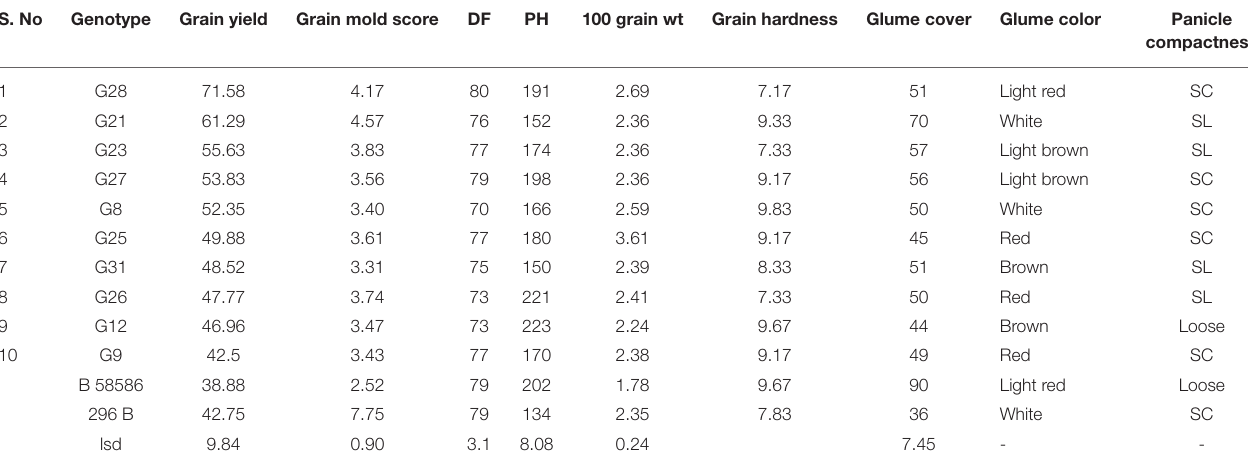
TABLE 8 | Some lines promising for both GY and grain mold. S. No